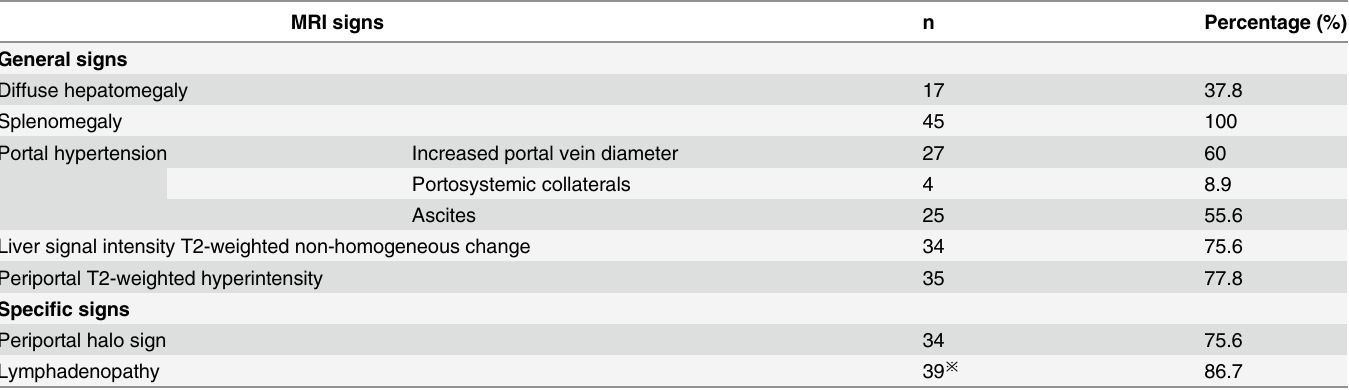
Table 3. MRI findings.